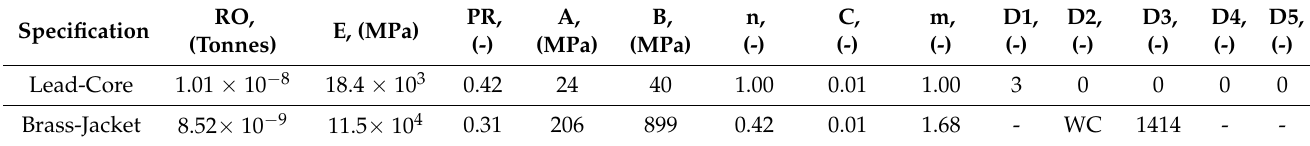
Table 2. Parameters of the * MAT_107 ‐ MODIFIED_JOHNSON_COOK model for projectile.